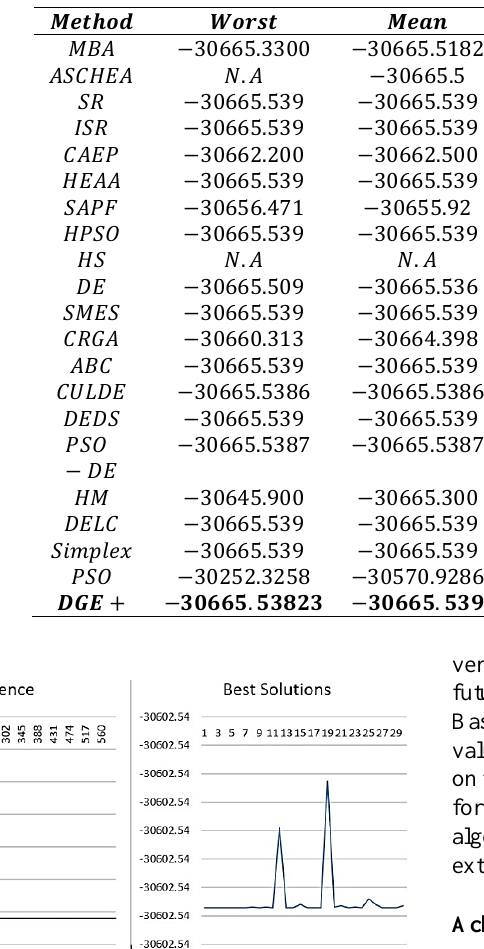
Table 15. Statistical comparison of results for constrained problem 7 of various algorithms